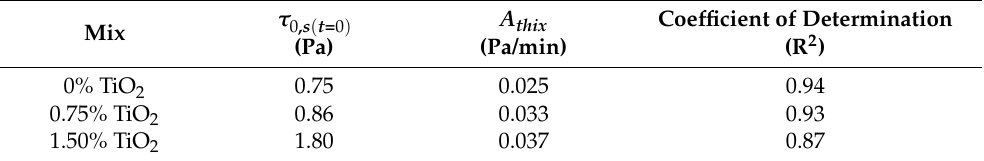
Table 3. Structuration rate parameters of the pastes.